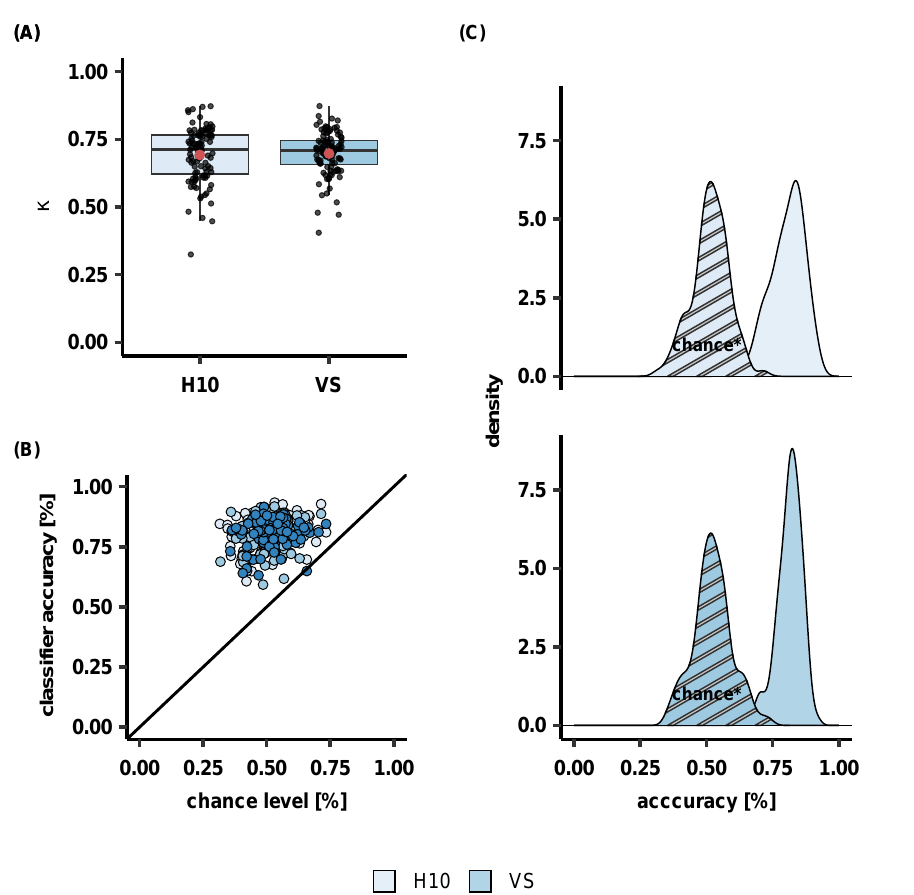
Figure 3. MCNN performance on classifying IBIs against automatic PSG sleep staging as expressed with ( A ) κ values, and ( B ) classification accuracies that are visualized also using ( C ) accuracy density plots with corresponding chance levels* for both low-cost sensors H10, and VS. * The chance level is computed by sleep staging only light sleep which appears to be enough to reach 50% accuracy. Note that sleep staging only with light sleep is sufficient to achieve an accuracy of around 50%.